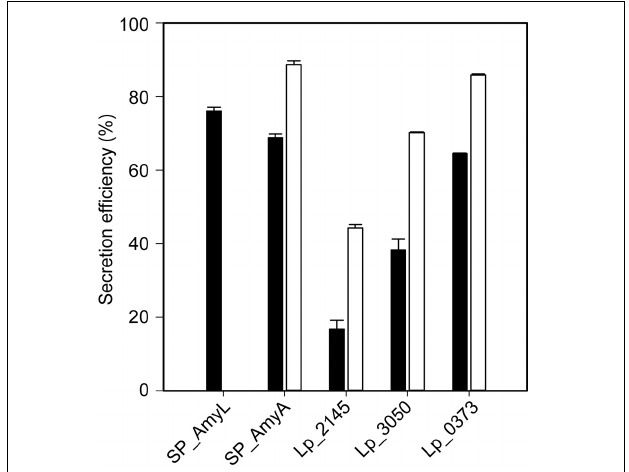
FIGURE 5 | The pair-wise variation generated by geNorm to determine the optimal number of reference genes for accurate measurement of mRNA levels using RT-qPCR. A V -value lower than the standard cut-off of 0.15 is considered